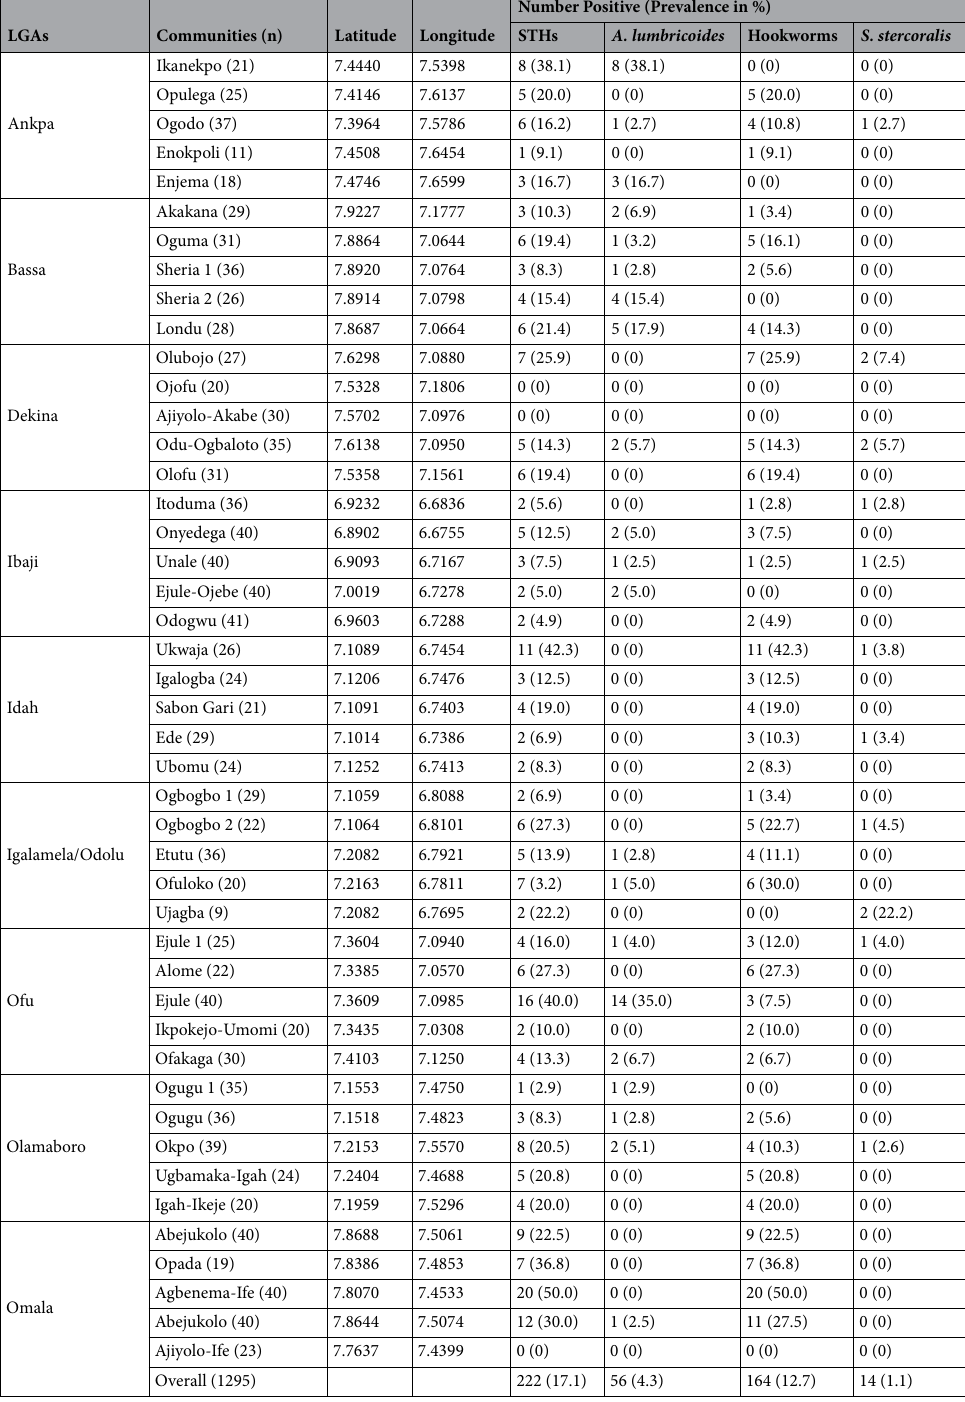
Table 1. Epidemiological Data from District Wide Survey Conducted in 2018 by Yaro et al. (2020) in Kogi East, North Central Nigeria. n – Number